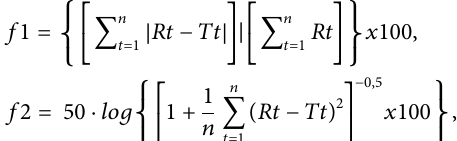
Frontiers in Chemistry |